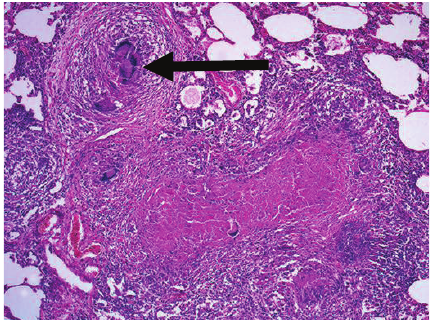
Figure 2: Arrow indicating caseating